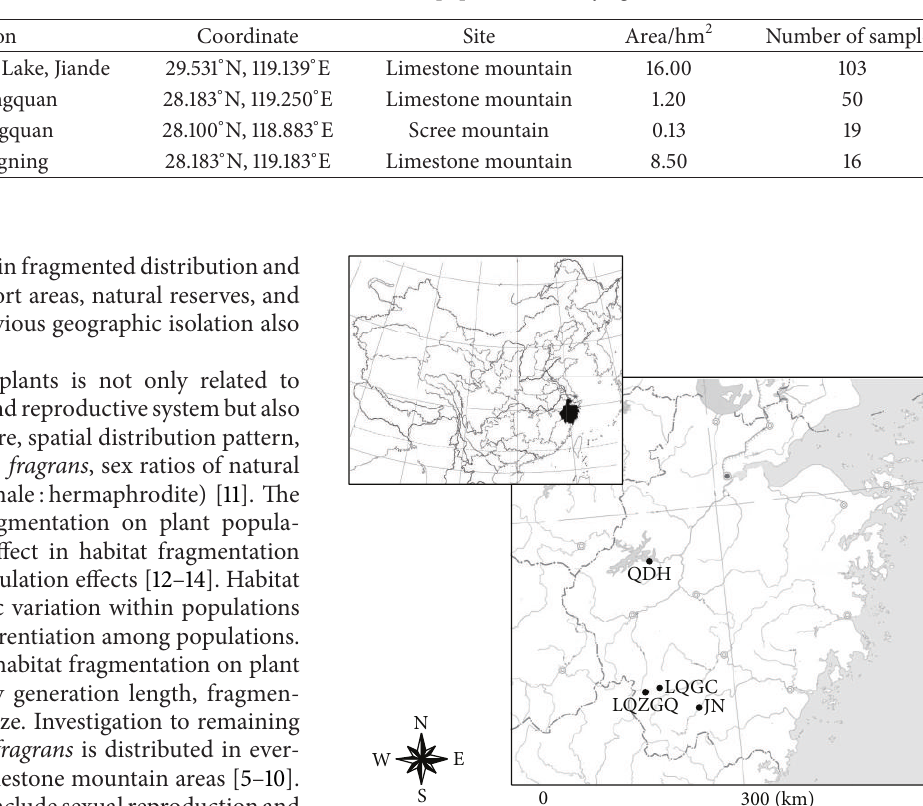
Table 1: Locations and distributions of four natural populations in O. fragrans .